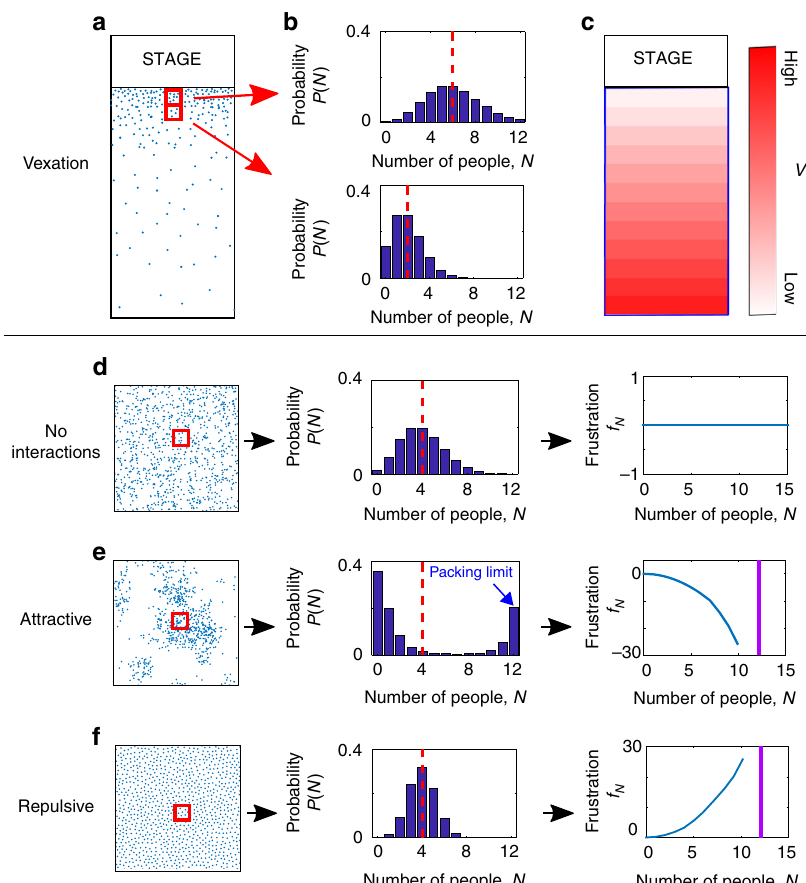
Fig. 1 Resulting density-functional approach. a Schematic of crowd in which agents attempt to get as close to the stage as possible while avoiding overcrowding. b In the absence of interactions, the mean of each probability distribution (vertical dashed line) indicates location preference, from which we can extract a bin-dependent vexation functional, v b . c Resulting bin-dependent vexations. d – f Crowds in environments with uniform vexation but with neutral, repulsive, or attractive interactions. For neutral interactions, we expect complete spatial randomness leading to Poisson distributed counts within each bin. The repulsive and attractive interactions are thus re fl ected in the deviation of the probability distribution from the Poisson form 26 . From these deviations we can extract a bin-independent frustration functional, f N , whose curvature indicates the nature and intensity of the